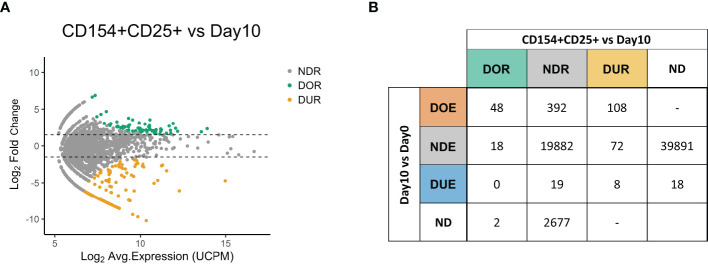
Expression of the activation markers CD154 and CD25 confirms the antigen-responsiveness of Differentially Over-Expanded TCR clones. (A) MA plot showing the changes in frequency in individual TCR clones when comparing the CD154+CD25+ sorted fraction after re-stimulation with antigen at day 10 to the day 10 repertoire. Each dot represents an individual TCR clone where the x- and y-axes depict the average log2 clonal frequency (calculated from UMI counts per million; UCPM) and log2 fold change compared to day 10 respectively. Differentially (Benjamini–Hochberg corrected p-value <0.05) Over-Represented clones (DOR, fold changes >1.5) are colored in green, Differentially Under-Represented clones (DUR, fold changes < −1.5) are colored in yellow, while Not Differentially Represented clones (NDR, −1.5 < fold changes <1.5) are colored in gray. (B) Cross-table showing the overlap between clones defined as Differentially Over-Expanded (DOE), Not Differentially Expanded (NDE) or Differentially Under-Expanded (DUE) in the day 10 to day 0 repertoire comparison, and clones defined as Differentially Over-Represented (DOR), Not Differentially Represented (NDR) or Differentially Under-represented (DUR) clones in the sorted CD154+CD25+ fraction to day 10 repertoire comparison. ND, Not Detected.